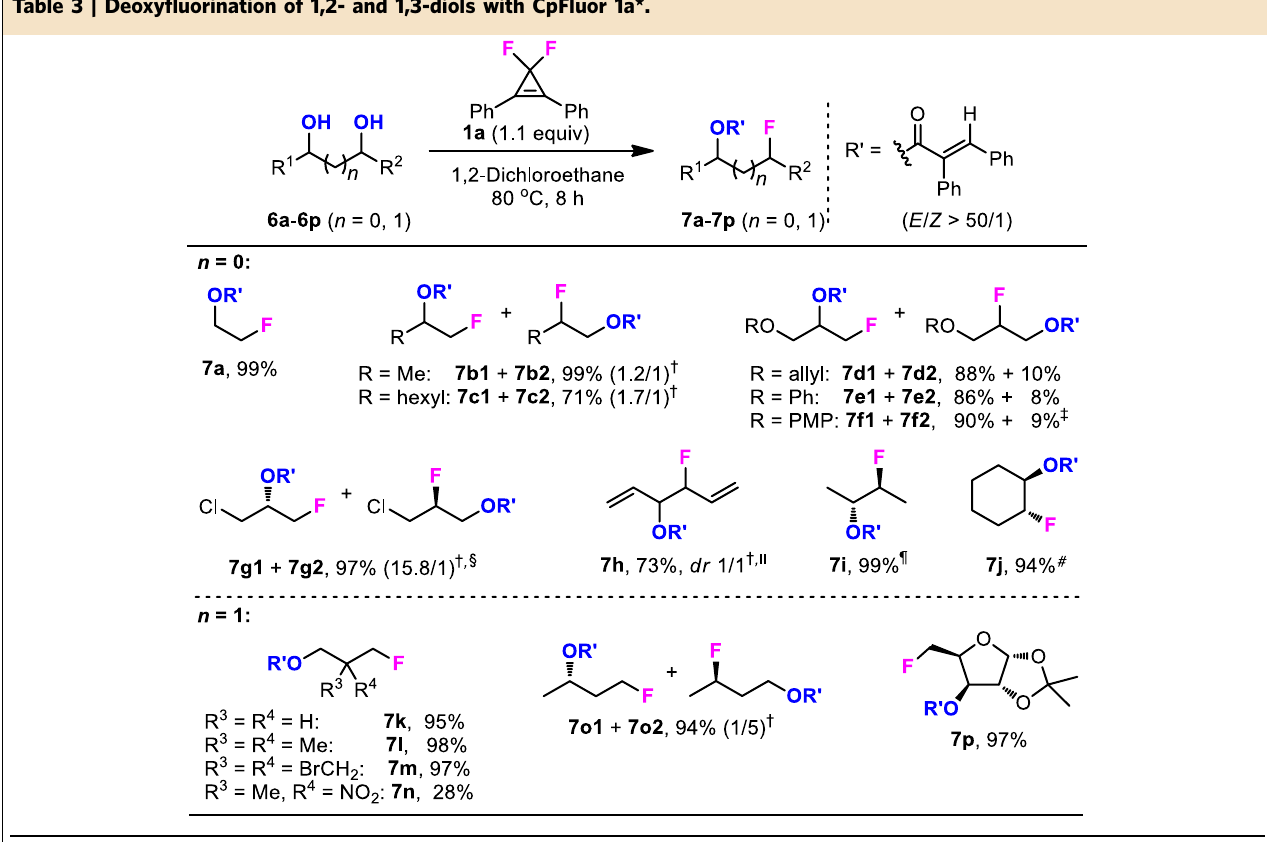
Table 3 | Deoxyfluorination of 1,2- and 1,3-diols with CpFluor